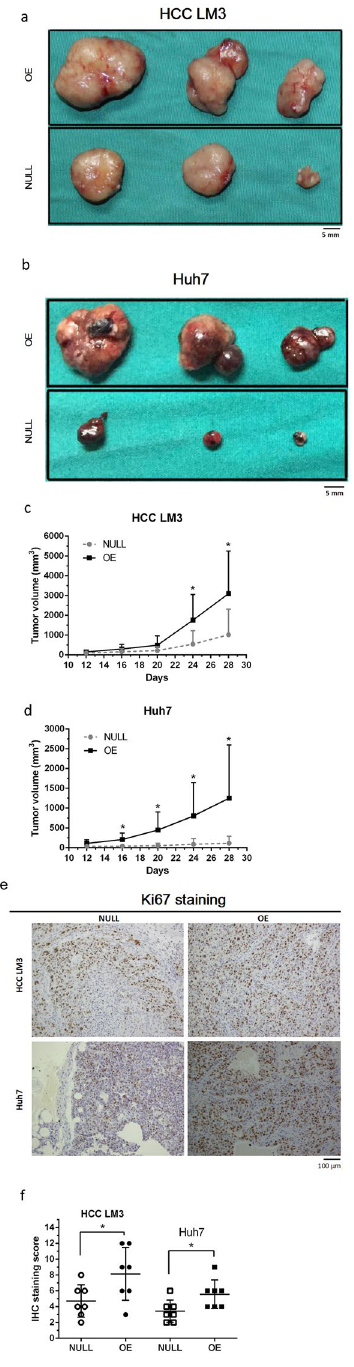
Figure 3. Overexpression of PANDA promotes liver cancer tumorigenesis in vivo . Mice bearing HCC LM3 ( c ) cells and Huh7 ( d ) cells with higher expression of PANDA (OE) had larger xenograft tumor sizes compared with control group (NULL). Representative pictures of 3 specimens from both groups were shown in ( a , b ) respectively. IHC staining of proliferation marker, Ki67 was consistently stronger in OE group than NULL group ( e ). IHC staining scores were analyzed in ( f